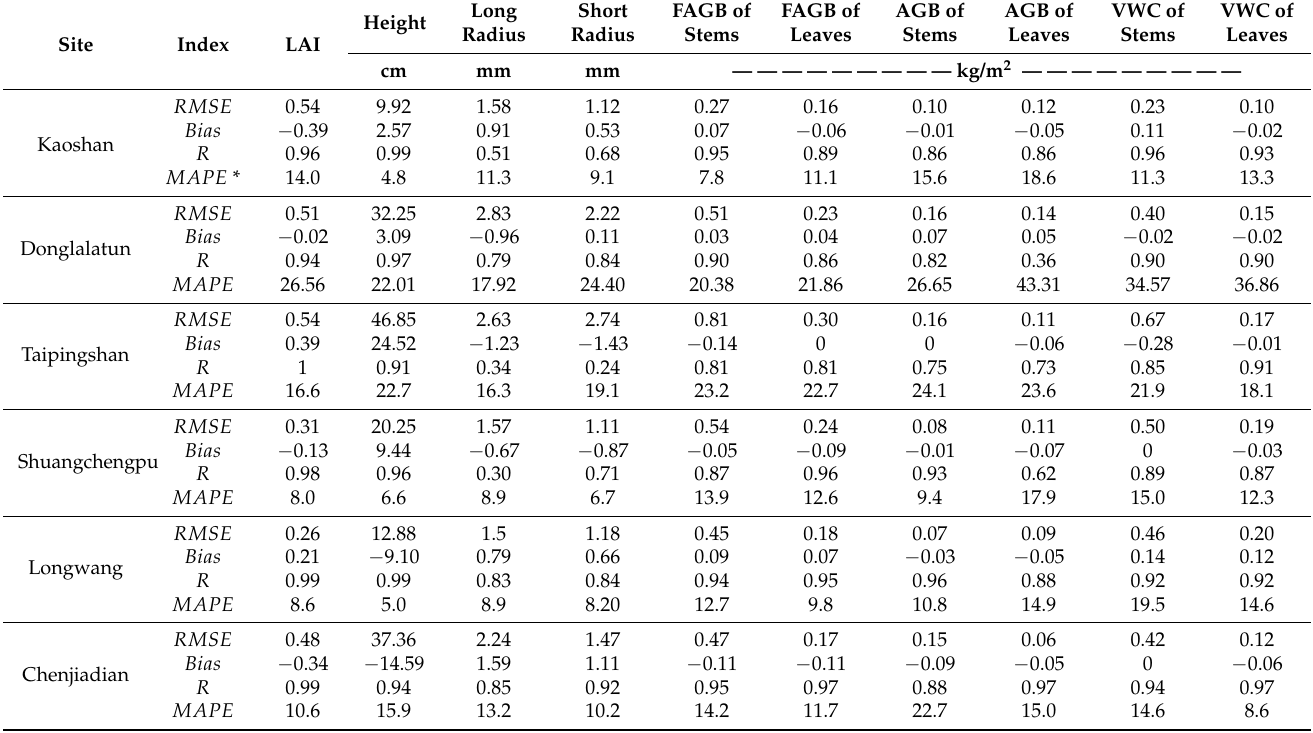
Table A1. The evaluation indicators of the accuracy in the canopy parameters simulated by the MODIS LAI as the input parameter were compared with the field observations for each site and all sites